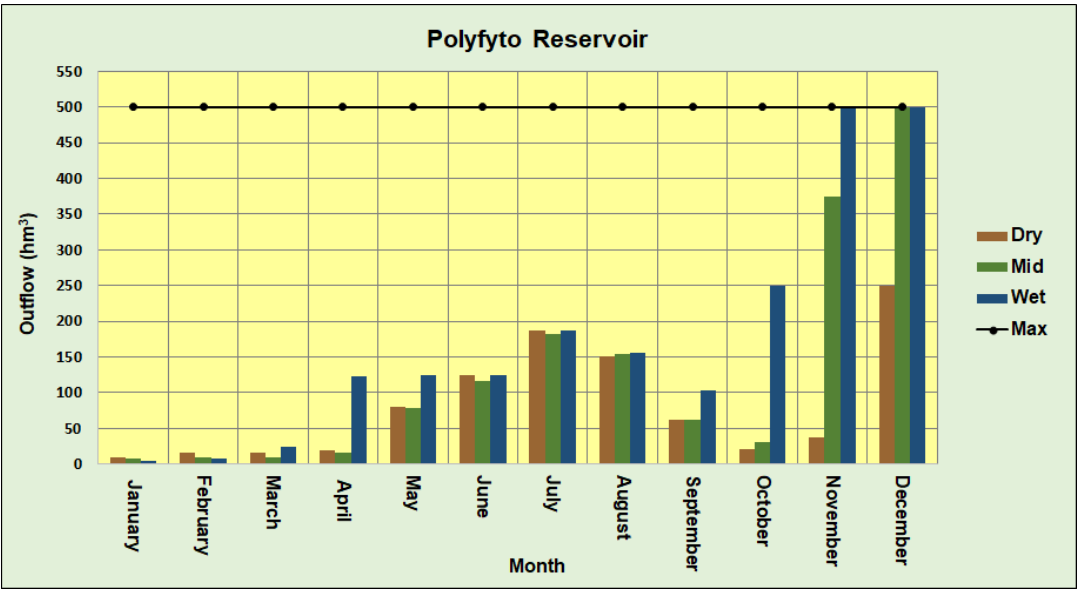
Figure 9. The optimal outflows for the current state of water resources demand, ignoring the institutional operating rule curves for Polyfyto reservoir.